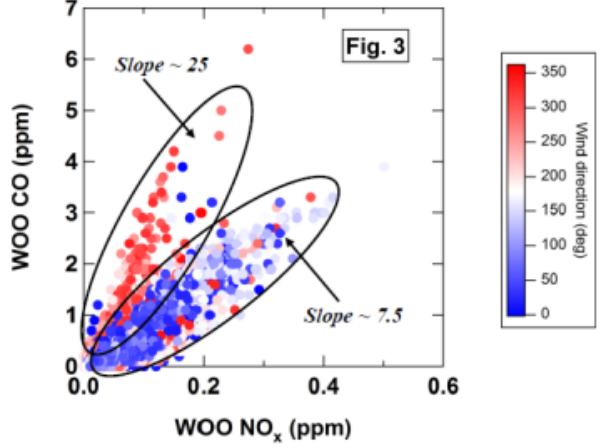
Fig. 3. Scatter plots of CO WOO versus NO x, WOO